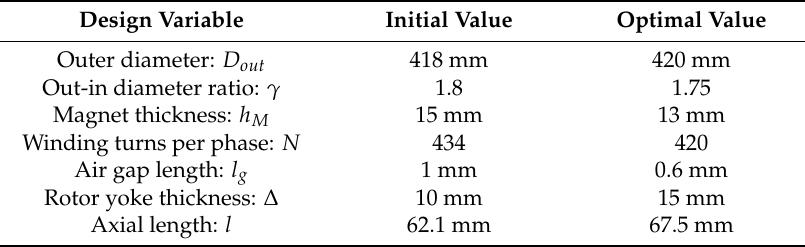
Table 2. Design variables of the AFPMSG before and after